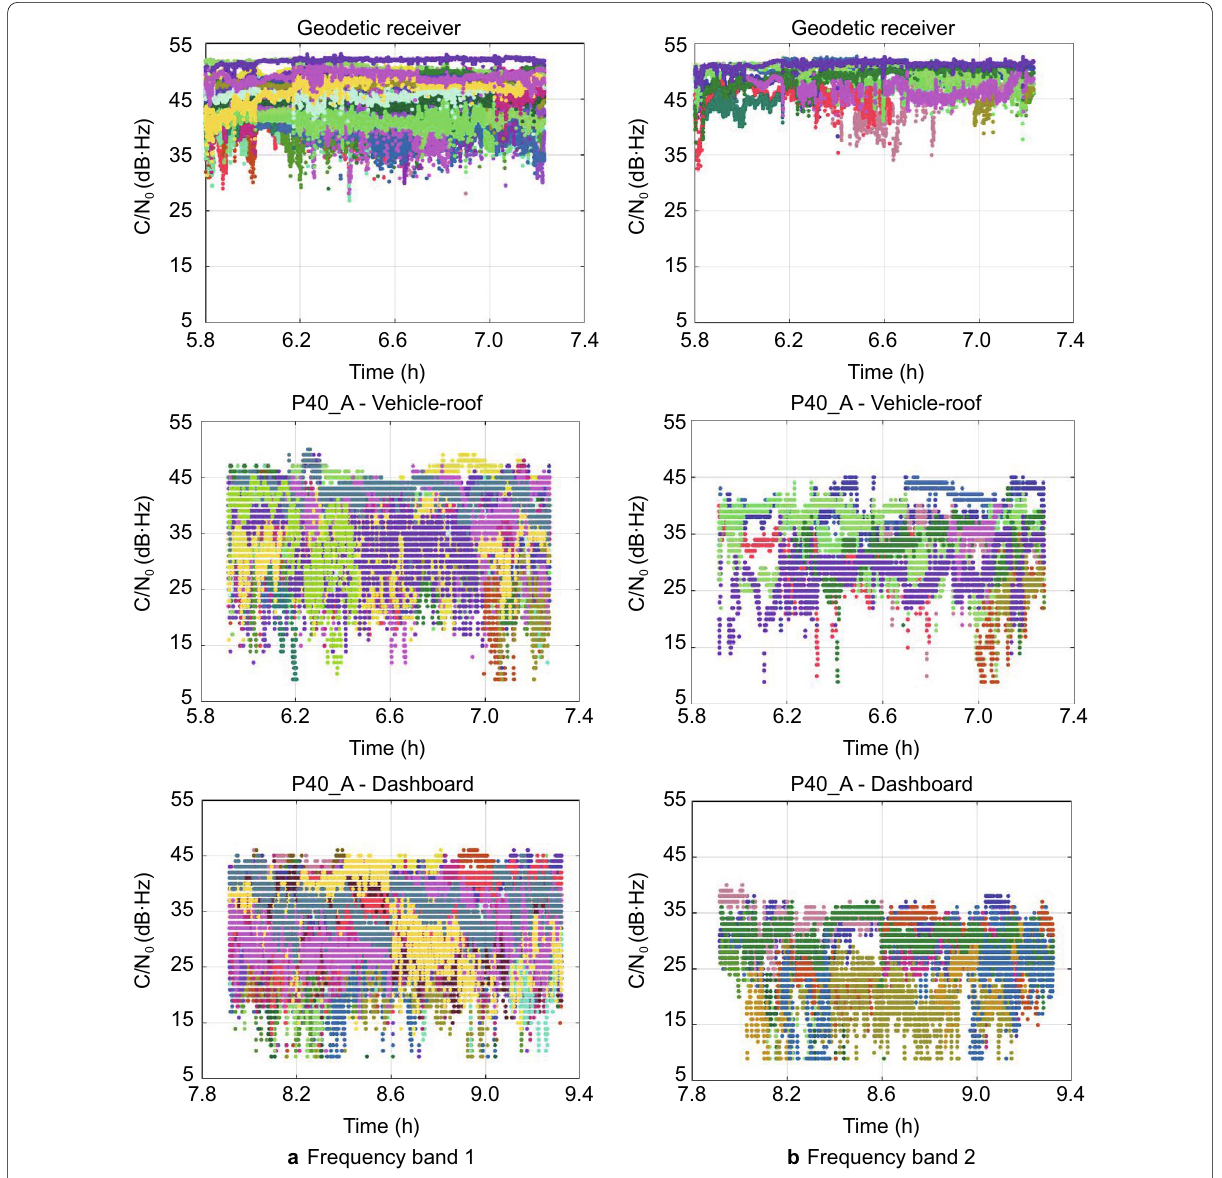
Fig. 3 The dual-frequency C/N 0 values of the experimental smartphones and geodetic receiver in the vehicle-roof and dashboard modes: taking the P40_A smartphone as examples: a for frequency band 1, b for frequency band